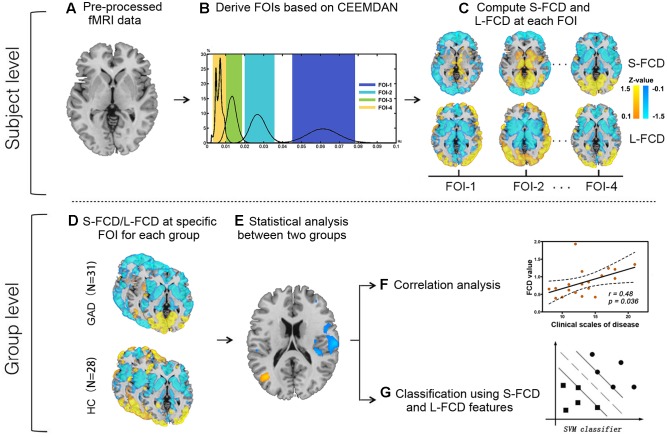
Flow diagram illustrating the proposed research framework. CEEMDAN, complete ensemble empirical mode decomposition with adaptive noise; S-FCD, short-range functional connectivity density; L-FCD, long-range functional connectivity density; FOI, frequency of interest; GAD, generalized anxiety disorder; HC, healthy control.